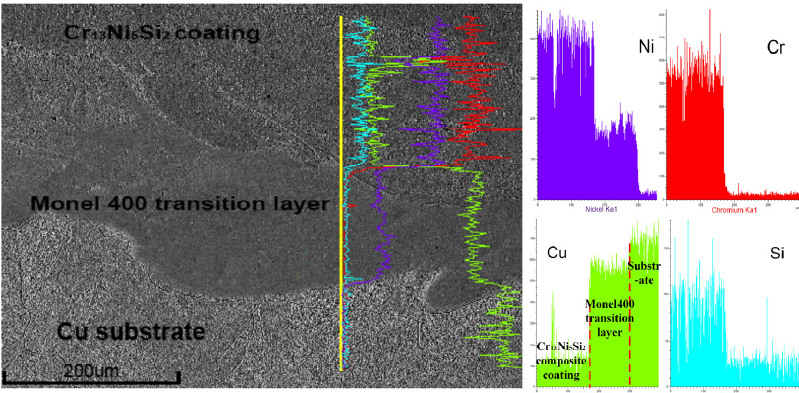
Figure 9. Line scan result of the Cu substrate–Monel400 transition layer–Cr 13 Ni 5 Si 2 composite coating.